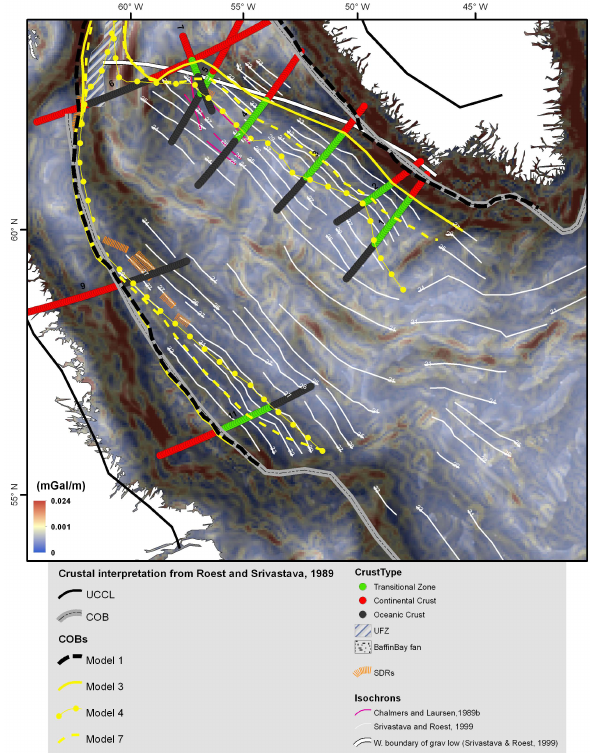
Fig. 2. Interpreted crustal structure and alternative COB models in the Labrador Sea shown overlying Bouguer gravity (derived from EGM08). UCCL (black) line is the same for all models. Four al- ternative COB interpretations are shown: model 1 (dashed black line) is based on Roest and Srivastava (1989) crustal interpreta- tion, model 3 (continuous thick yellow line) is the most landward COB (same as model 2 in the Labrador Sea), model 4 (yellow line with circles) is the most oceanward COB (same as model 5 in the Labrador Sea) and Model 7 (dashed yellow line) interprets the COB within the range of the transitional zone (same as model 6 in the Labrador Sea). The numbering for seismic lines is the same as Fig.